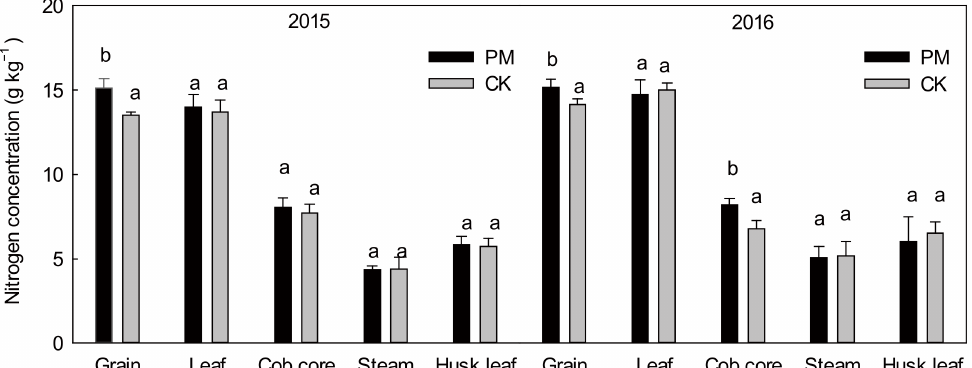
Figure 2. Nitrogen concentration in different aboveground organs under plastic mulching and non- mulching at harvest in 2015 and 2016. Means followed by different letters are significantly ( p < 0.05) different between film mulched and non-mulched. PM, maize mulched with plastic film; CK, maize without plastic mulch.